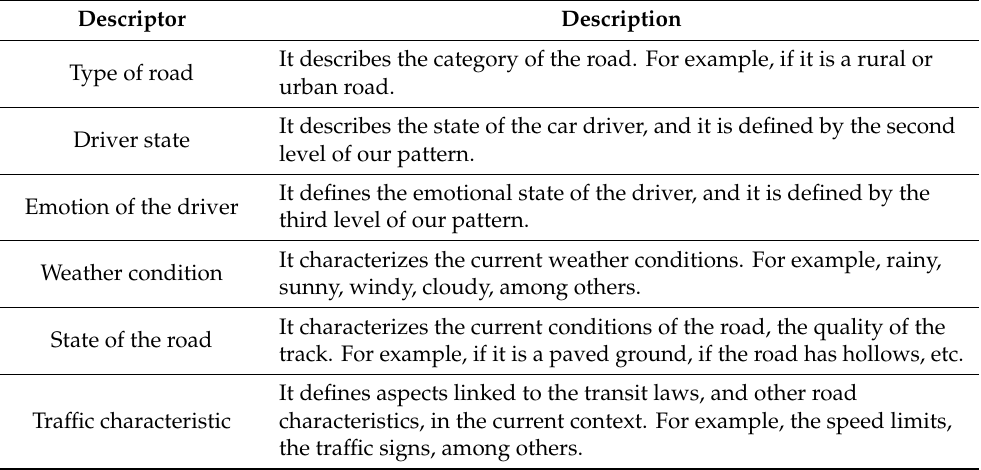
Table 1. Descriptors of the pattern of the driving style.